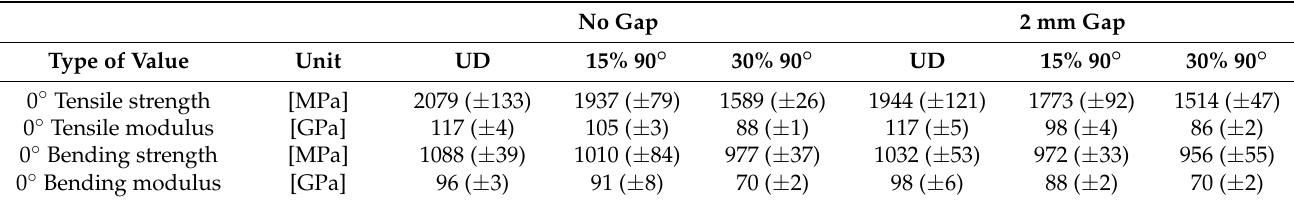
Table 6. Mechanical values of tensile and bending in the 0 ◦ direction, 8 mass-% binder content, FVF normalised to 55%, standard deviation in ()